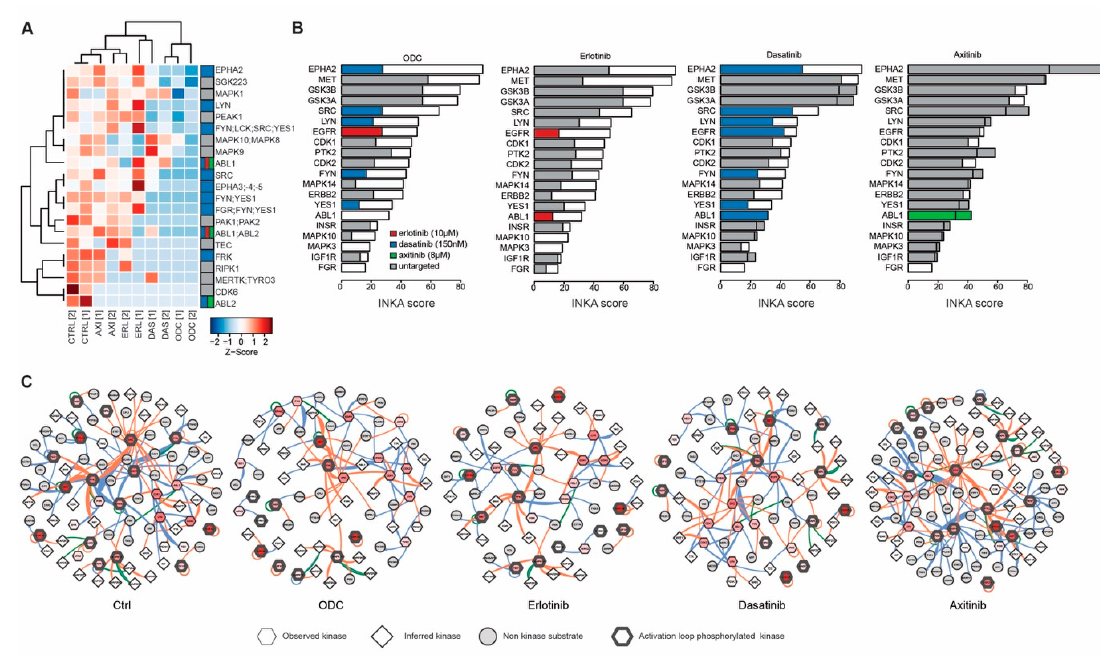
Figure 5. Effective protein kinase inhibition by ODC revealed by phosphoproteomics. ( A ) Heatmap of phosphokinase expression in 786-O treated with monotherapies and ODC which showed a significant difference between ODC and control. Note that the inhibitory effect of the broad spectrum inhibitor dasatinib is dominant in the ODC given their close clustering. ( B ) INKA profiles of untreated 786-O (white bars; outlined) with profiles after the indicated treatments superimposed in color. Kinases are color coded by the respective drugs. Absence of staining implicates the kinase was not present in the top 20 INKA scores after treatment, and untargeted kinases are shown in grey. ( C ) Network plots of measured kinases, substrates and inferred kinases in INKA analysis before and after treatment. Blue lines indicate evidence by NWK, orange by PSP and green by both. Drug targeted kinases are color coded in red by increasing INKA score. Representative plots of duplicate analyses are shown in ( B , C ).